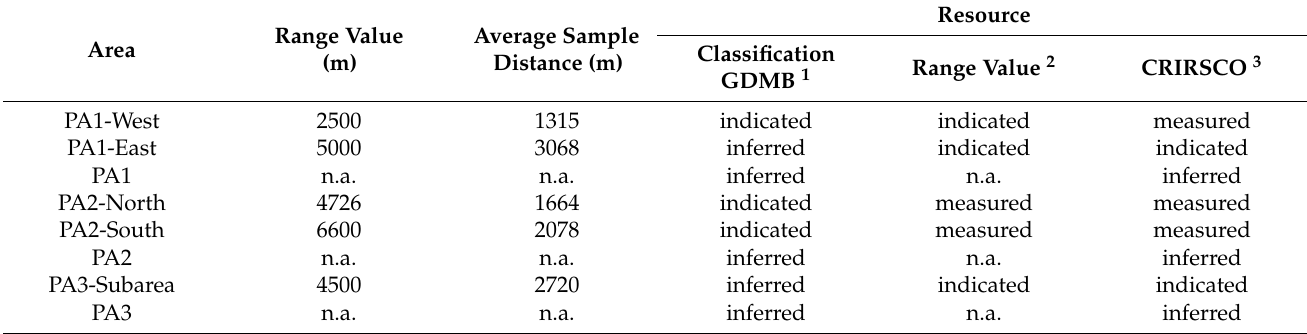
Table 11. Resource classification of the prospective areas based on different classification schemes.